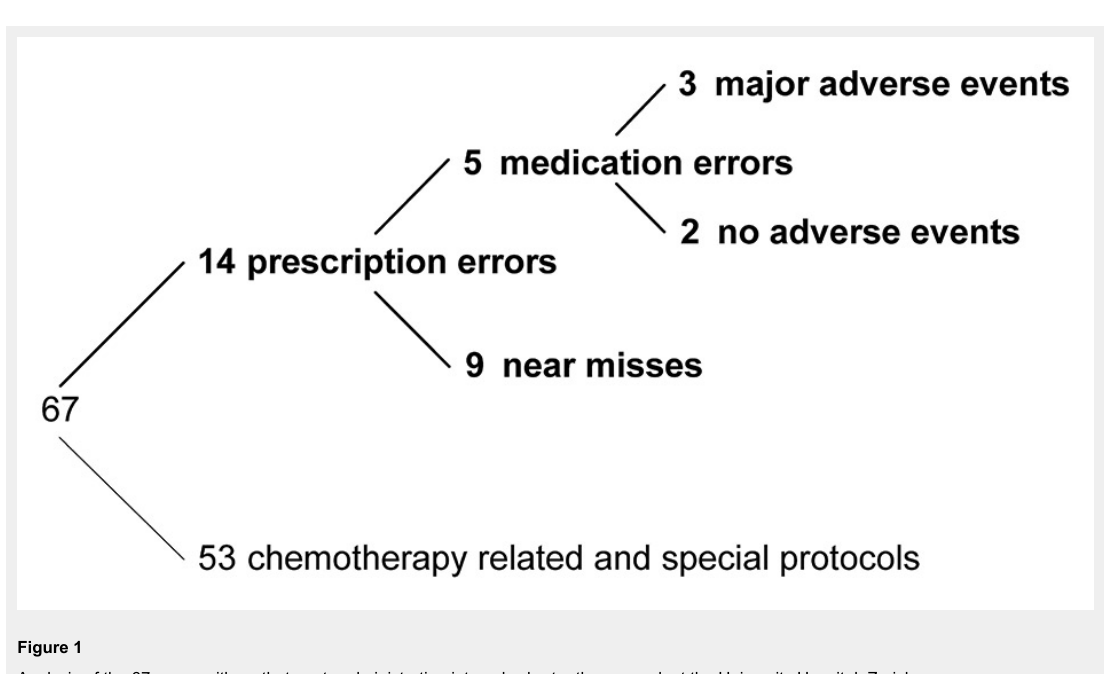
Figure 1 Analysis of the 67 cases with methotrexate administration intervals shorter than a week at the University Hospital,